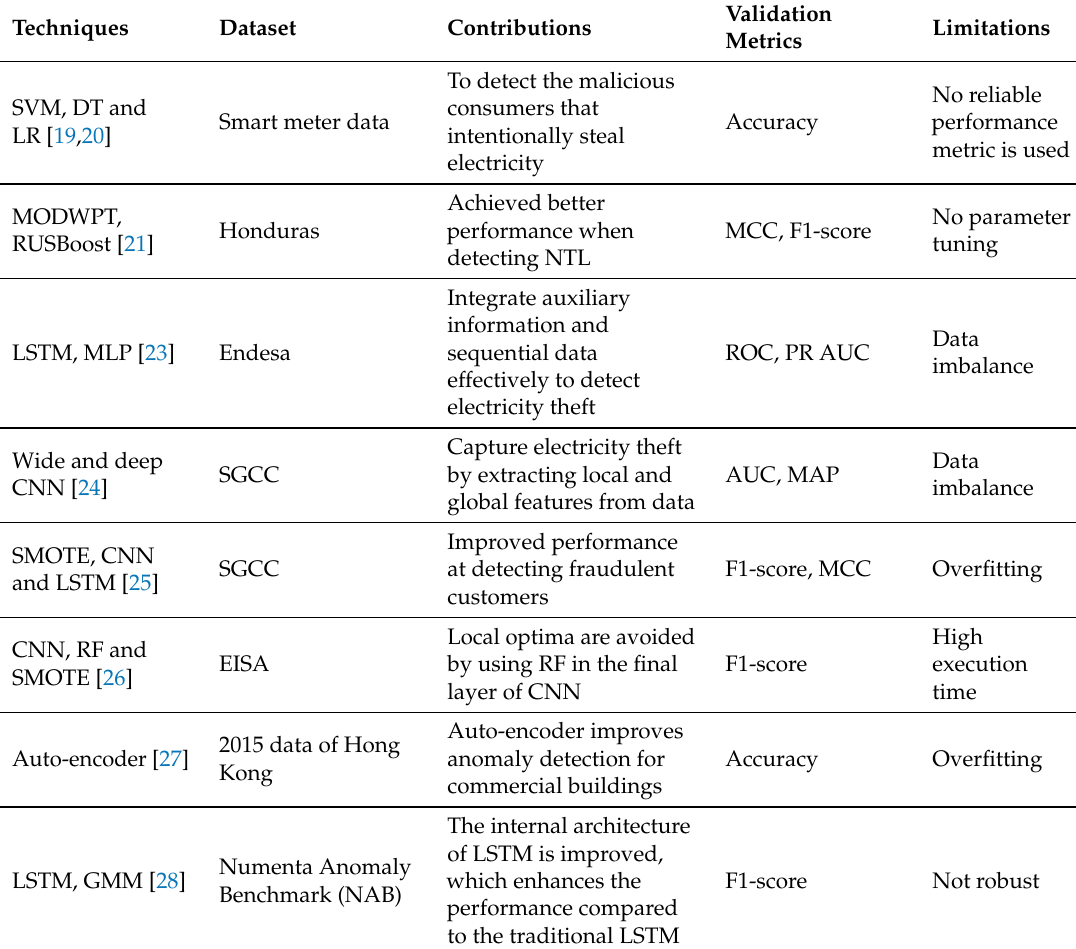
Table 3. Performance of supervised machine learning techniques in the literature. SVM: support vector machine; LR: logistic regression; MODWPT: maximum overlap packet transform; MLP: multi-layer perceptron; AUC: area under the curve; CNN: convolutional neural network; SGCC: State